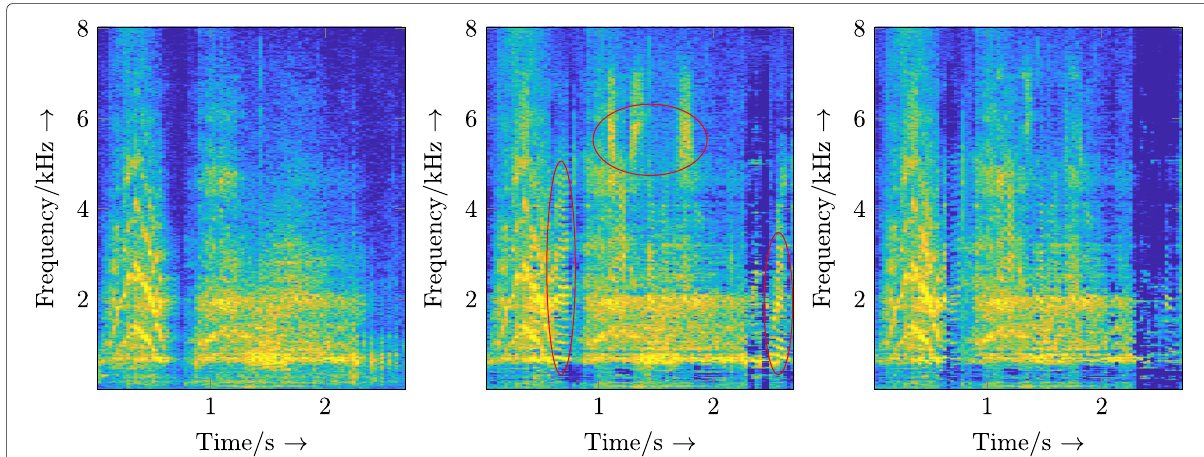
Fig. 7 Spectrograms of an exemplary ego-noise extract from Sequence II (logarithm of magnitude). The left figure shows the original ego-noise. In the center and right figures, ego-noise estimates using audio-only NMF and the proposed method are depicted, respectively. Without motor data regularization, the ego-noise is in parts incorrectly estimated and adapts to the speech signal. Corresponding components are marked with red ellipses (middle). Note that these undesired components are not or significantly less visible in the ego-noise estimate of the proposed method (right)